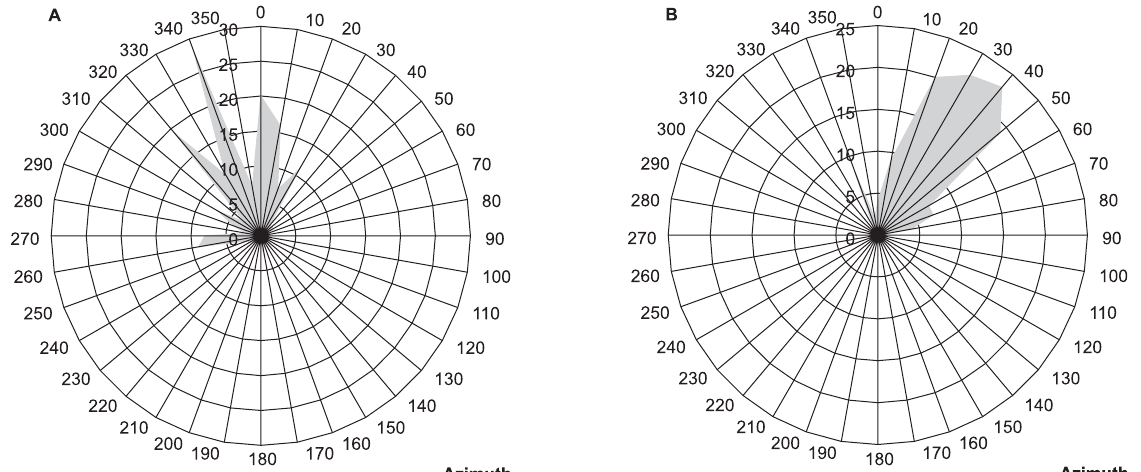
Fig. 3. Average frequency (%) of the wind directions at the meteorological station in Laâyoune on 03–12.03.2010 (A) and 25.02–01.03.2012